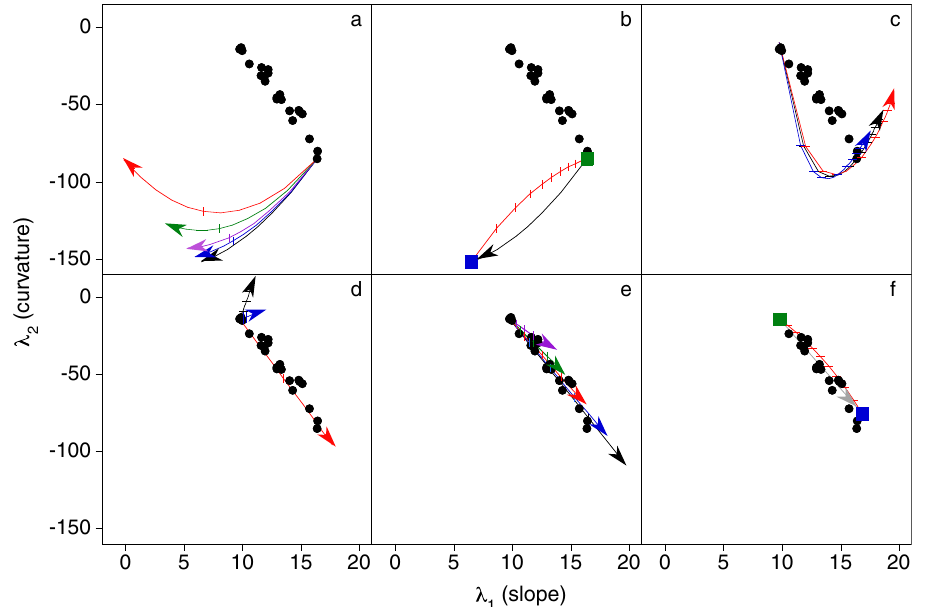
Fig. 3 Modelled trends in the curvature ( λ 2 ) and slope ( λ 1 ) of rare earth element (REE) patterns due to partial melting, fractional crystallisation, reactive melt fl ow and binary mixing. The λ 2 and λ 1 and of the basanite-nephelinite glasses (black symbols) and trends in curvature and slope of the REE pattern of a melt due to a partial melting starting at the λ 1 λ 2 of the most evolved sample for 10% total melting (5% interval marked) where the relative proportions of clinopyroxene, orthopyroxene and olivine contributing to the melt are constant but the amount of garnet varies from 2 (black), 7 (blue), 14 (purple), 28 (green) to 50 (red) %, b linear mixing (red) of the most evolved sample (green square) and the melt (blue square) in ( a ) produced by 10% partial melting with 2% garnet (black vector), intervals of 10% are marked, c reactive fl ow of the least evolved melt fl owing through a matrix of garnet peridotite with constant porosity (0.05; black), decreasing porosity (0.05 – 0.01; red) and increasing porosity (0.05 – 0.1; blue), intervals corresponding to a fl ow distance of 3, 7, 10% and then 10% increments to 80% are marked, d fractional crystallisation of 20% of garnet (red; i.e., 80% melt remaining), 40% clinopyroxene (blue) and 40% amphibole (black) from the least evolved sample, 10% intervals of crystallisation are marked, e fractional crystallisation of 40% garnet (gt) and clinopyroxene (cpx; i.e., 60% melt remaining) from the least evolved sample, where the fractionating assemblage varies from gt:cpx 0.5:0.5 (black), 0.4:0.6 (blue), 0.3:0.7 (red), 0.2:0.8 (green) to 0.1:0.9 (purple), 10% intervals of crystallisation are marked, and f linear mixing (red) of the least evolved sample (green square) and the residual melt (blue square) produced after that sample has undergone 42% fractional crystallisation of an assemblage consisting of 32% garnet 68% clinopyroxene (grey vector), 10% intervals of mixing are marked. Arrows show the direction of the petrogenetic